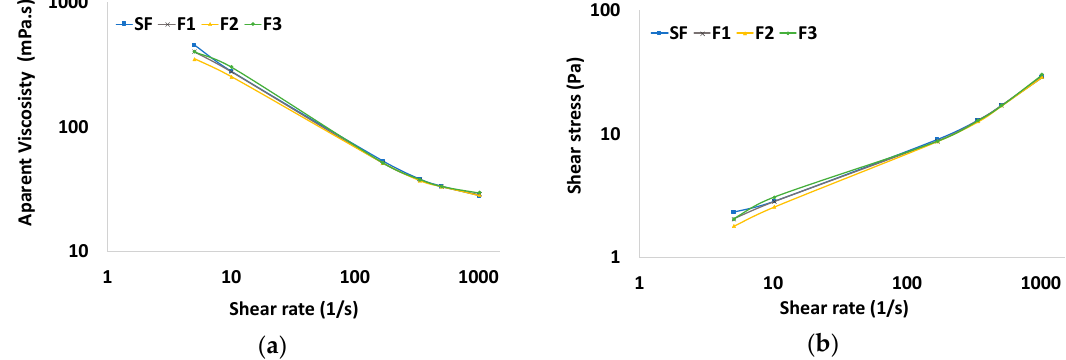
Figure 6. ( a ) Viscosity curves and ( b ) flow curves of the SF, F1, F2, and F3 drilling fluids.